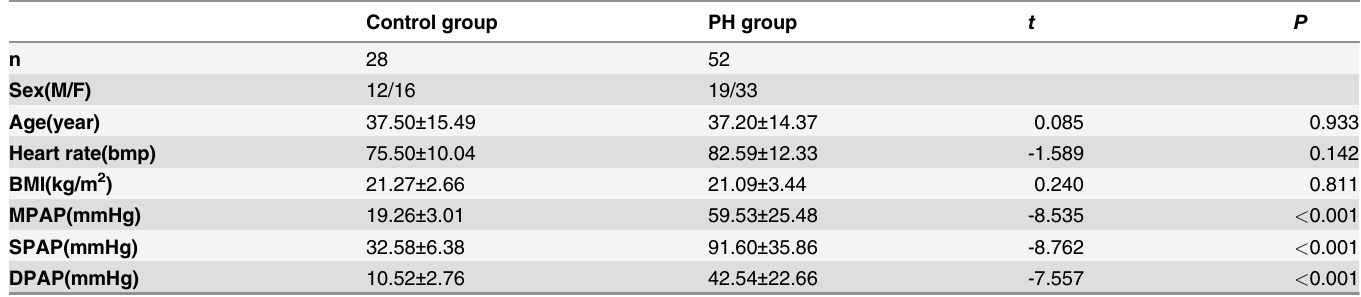
Table 1. Demographics and RHC Characteristics of the Study Population.